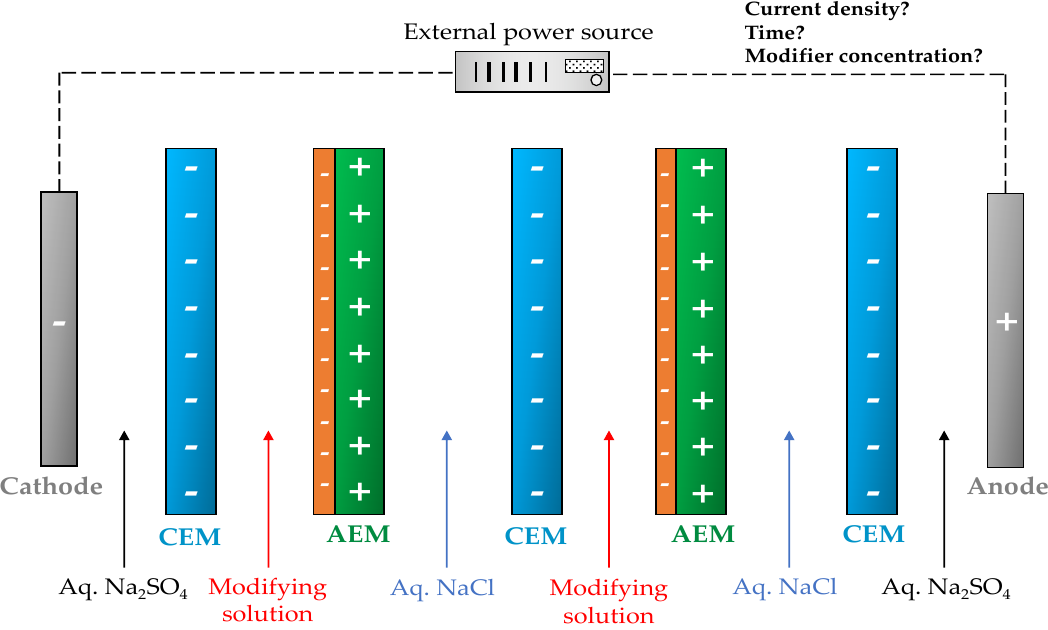
Figure 6. An example of a membrane stack, in which an external potential di ff erence is applied for creating a negatively charged modifying layer on AEMs by